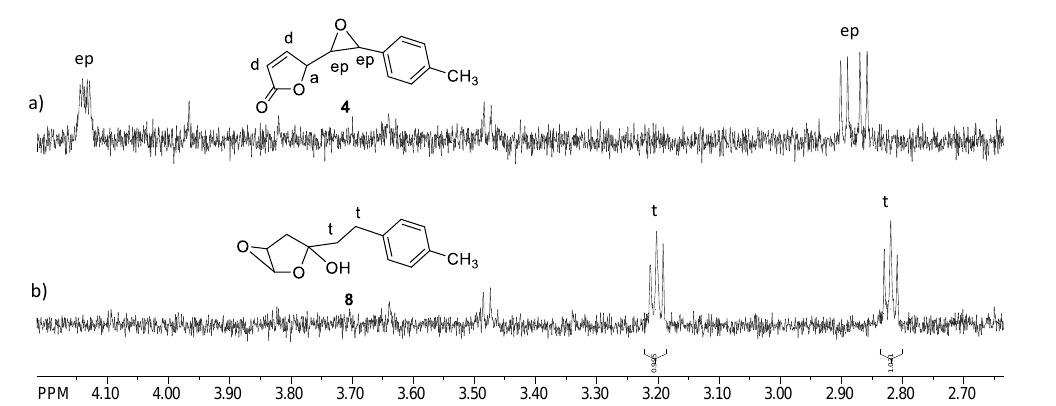
Figure 6. Aliphatic parts of 1 H NMR spectra (CDCl 3 ) of products 4 ( a ) and 8 ( b ) with characteristic patterns for assignation of the specific structures.